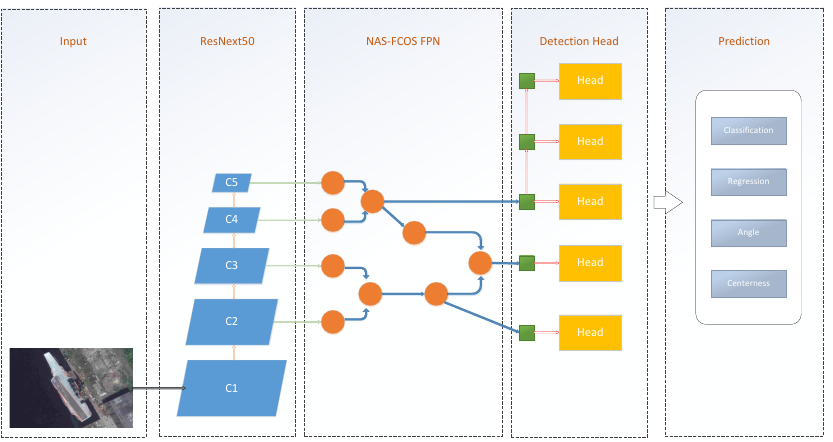
Figure 1. Network of